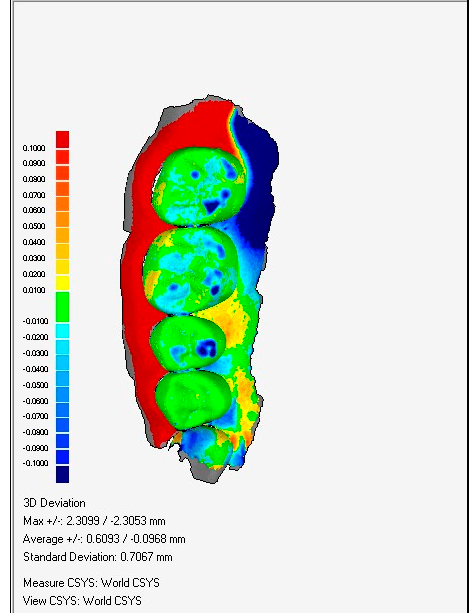
Figure 4. 3D comparing.